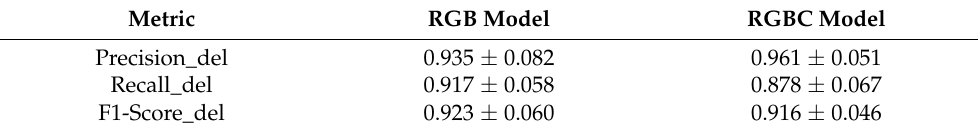
Table 4. Metrics results of delineation process.